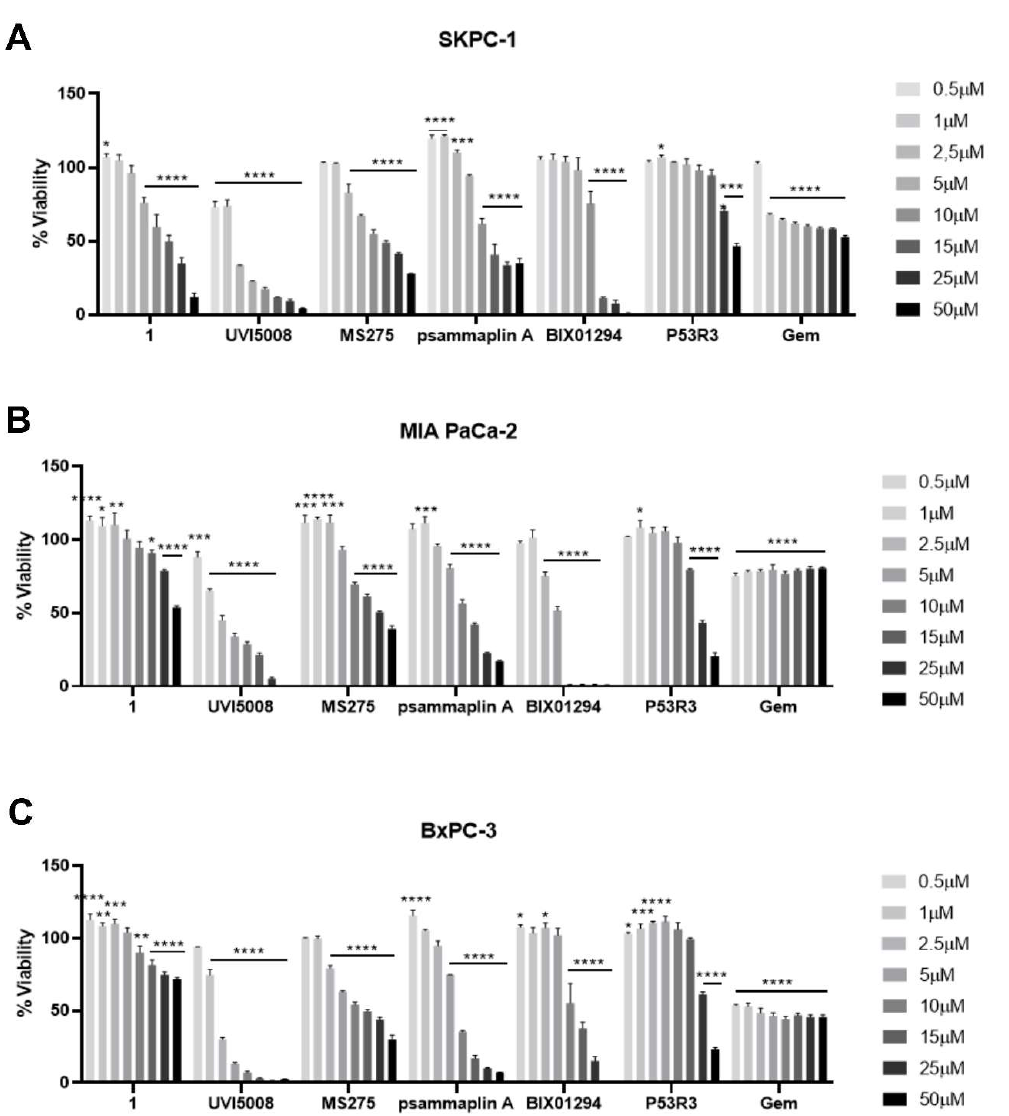
Figure 1. Antiproliferative effect induced by 1 (MS275 analogue), 2 (UVI5008), 3 (MS275), 4 (psammaplin A), 5 (BIX01294), 6 (P53R3), and gemcitabine (Gem) on three different pancreatic cell lines SKPC-1 ( A ), MIA PaCa-2 ( B ), and BxPC-3 ( C ) after 48 h of incubation, determined by MTS assay. Statistically significant differences compared to untreated cells were represented as: * p ≤ 0.05, ** p ≤ 0.01, *** p ≤ 0.001, **** p ≤ 0.0001.